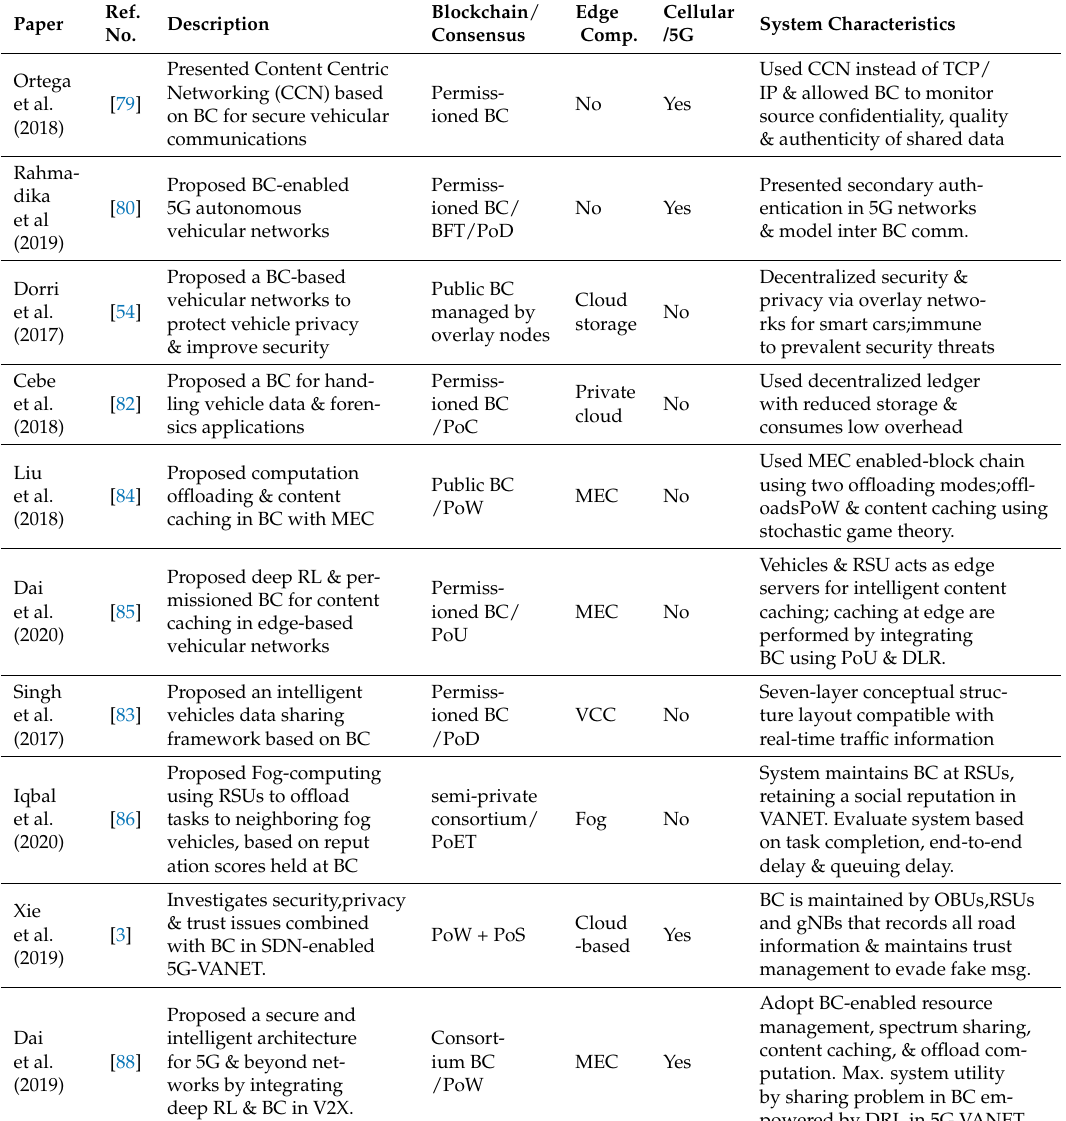
Table 8. A comparative study of Blockchain in advanced vehicular networks with 5G-based edge